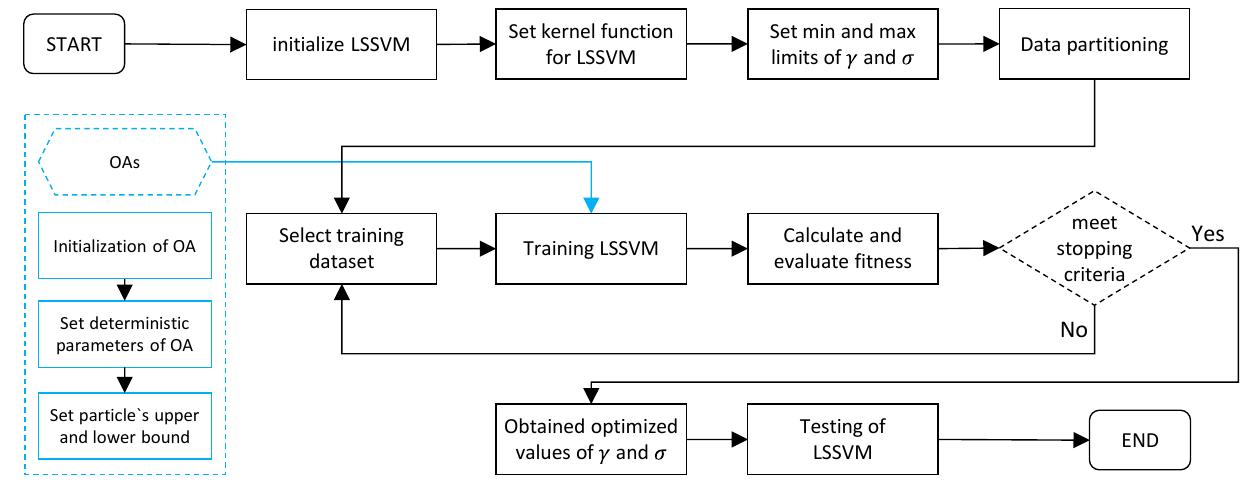
Figure 4. Construction procedure of hybrid LSSVM models.